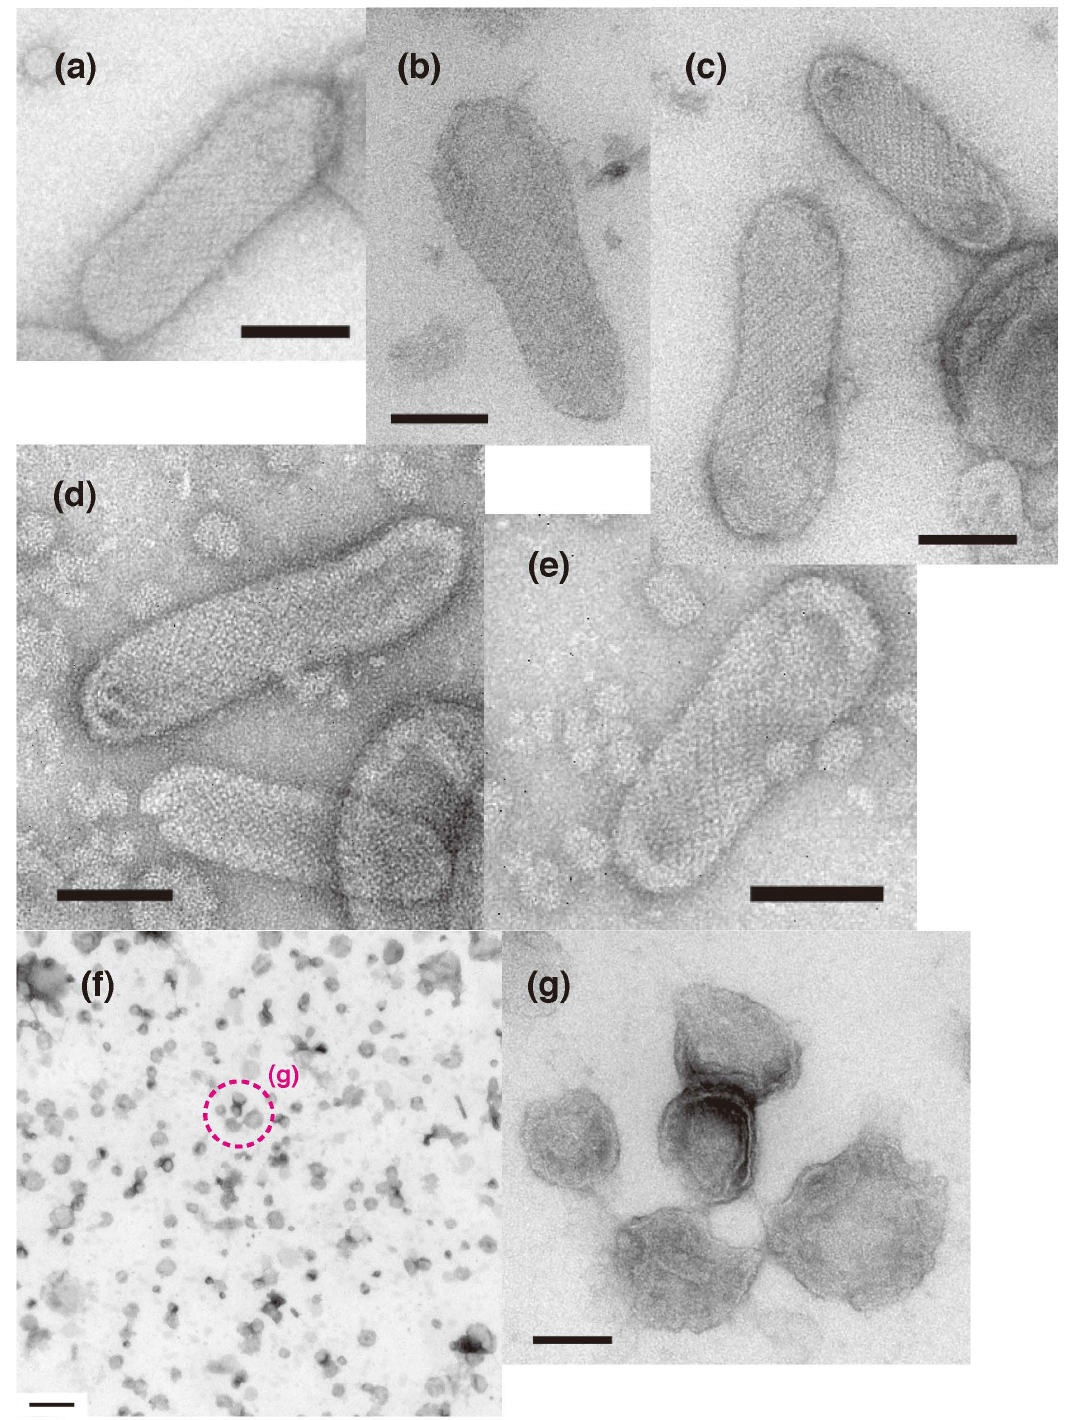
Figure 9. Time course of the morphology of SR vesicles during incubation at a low calcium con- centration (~0.002 µM) with 5 mM ATP. ( a – c ) SR vesicles after 1 min. ( d , e ) SR vesicles after about 2.5 h. Because all ATP present was consumed during the 2.5 h incubation (see main text), “two-rail” arrays degraded, and tetragon arrays dominated. In ( a – e ), before the addition of ATP, the SR preparation was preincubated at a low [Ca 2+ ] (~0.002 µM) for 5–9 min (see “Section 4. Materials and Methods”). ( f , g ) SR vesicles reacted with ATP for 1 min after overnight incubation at the low [Ca 2+ ] in the absence of ATP. Panel ( g ) is a higher magnification image of the dotted circle ( g ) in panel ( f ). Crystalline arrays were not observed. Scale bar in ( a – e , g ): 100 nm. Scale bar in panel ( f ) 0.5 µm.